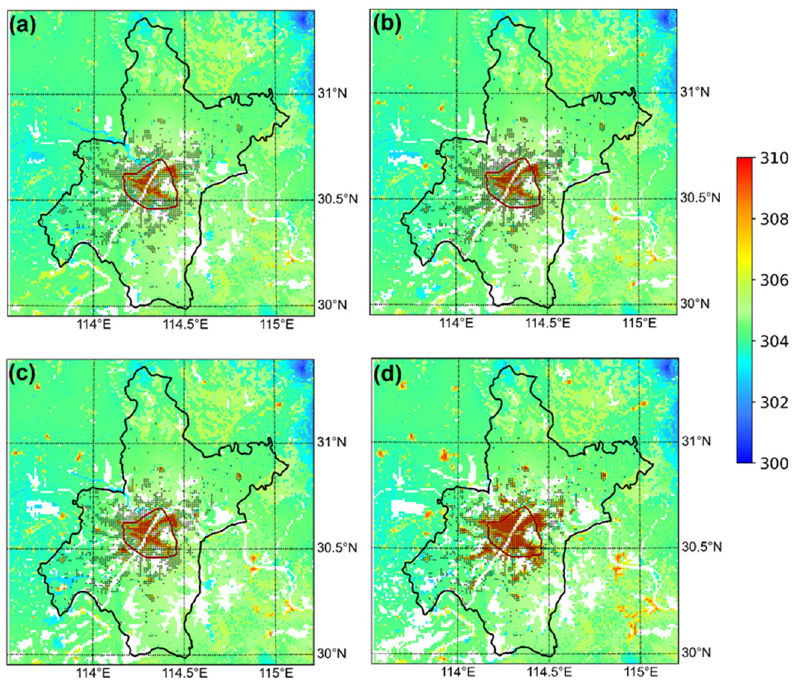
Figure 8. The spatial distribution of LST (Unit: K) in the case LULC1980 ( a ), LULC1990 ( b ), LULC2000 ( c ), and CNTL ( d ) averaged from 1 August to 15 August (the black point represents the urban grid in the CNTL).